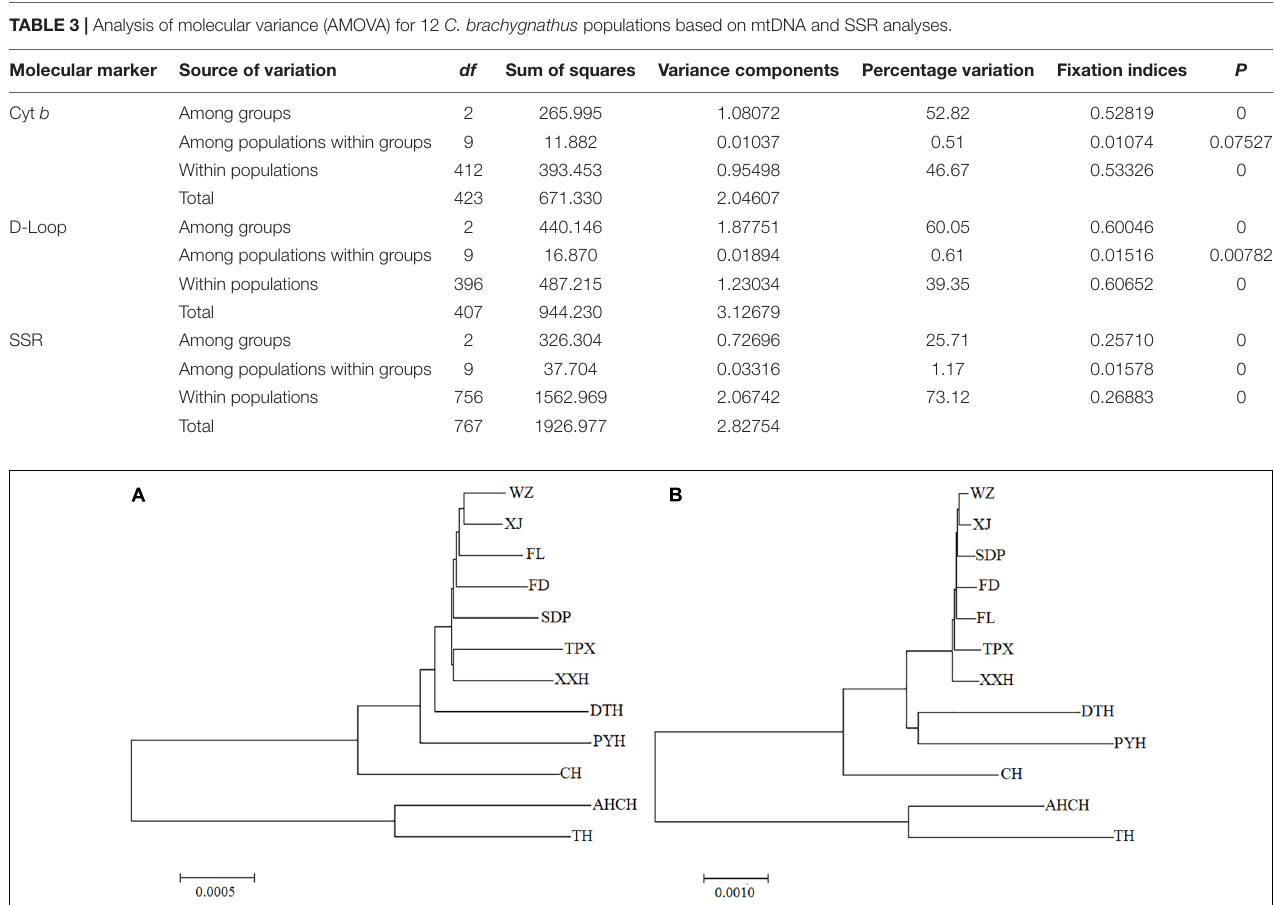
FIGURE 2 | Neighbor-joining tree of 12 C. brachygnathus populations based on K-2-P genetic distance of Cyt b (A) and D-Loop (B) genes.